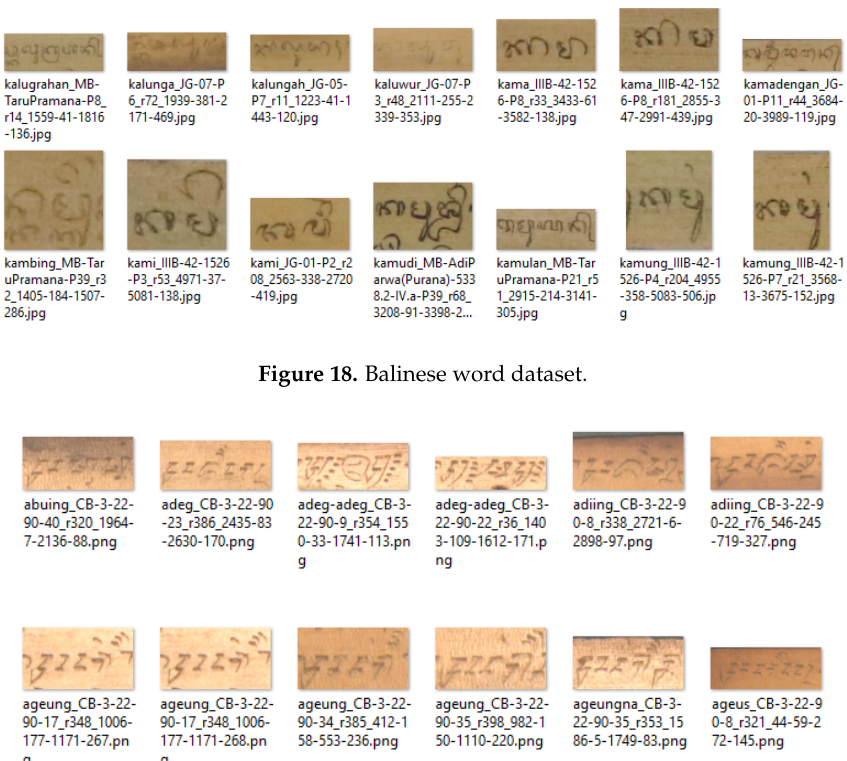
Figure 17. Khmer word dataset.